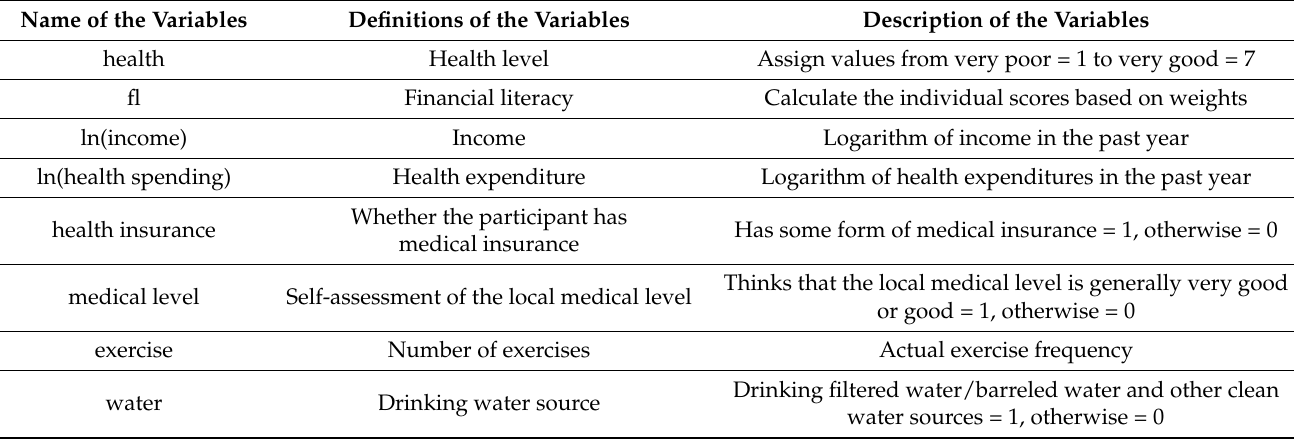
Table 1. Description of main